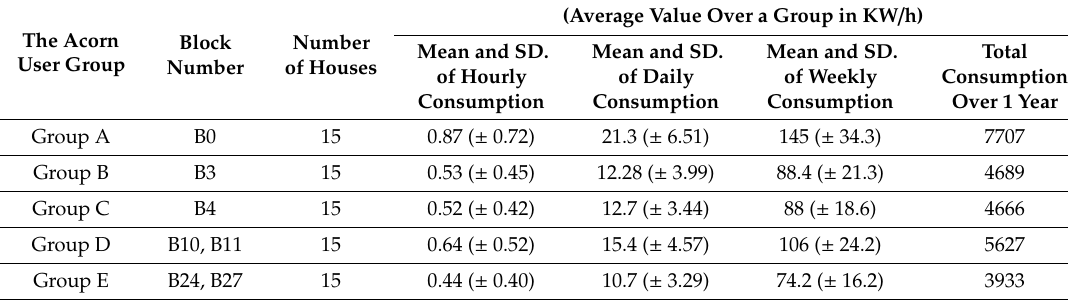
Table 1. Descriptive statistics of the